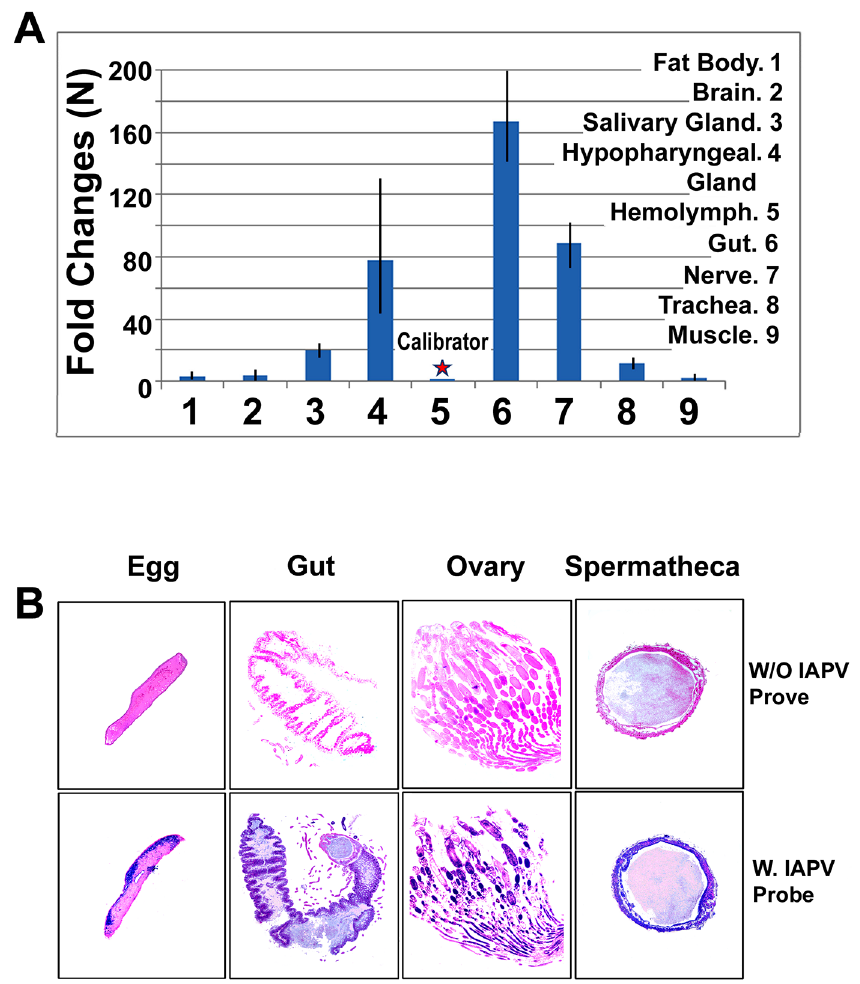
Figure 2. Relative abundance of negative strand RNA of IAPV genome copies in different tissues of honey bees and in situ hybridization analysis of queen somatic and germ tissues. ( A ) The hemolymph harbored the minimal level of IAPV and therefore was chosen as a calibrator. The concentration of negative strand RNA of IAPV in other tissues was compared with the calibrator and expressed as n-fold change. The y-axis depicts fold change relative to the calibrator. ( B ) The slides were not hybridized with DIG-labeled IAPV probe (top row, negative control) and the slides were hybridized with DIG-labeled IAPV probe (bottom row). Positive signal is dark blue to purple and the negative areas are pink in color. The infected tissues of queen gut, ovary, spermatheca and queen eggs are indicated by a dark blue/purple